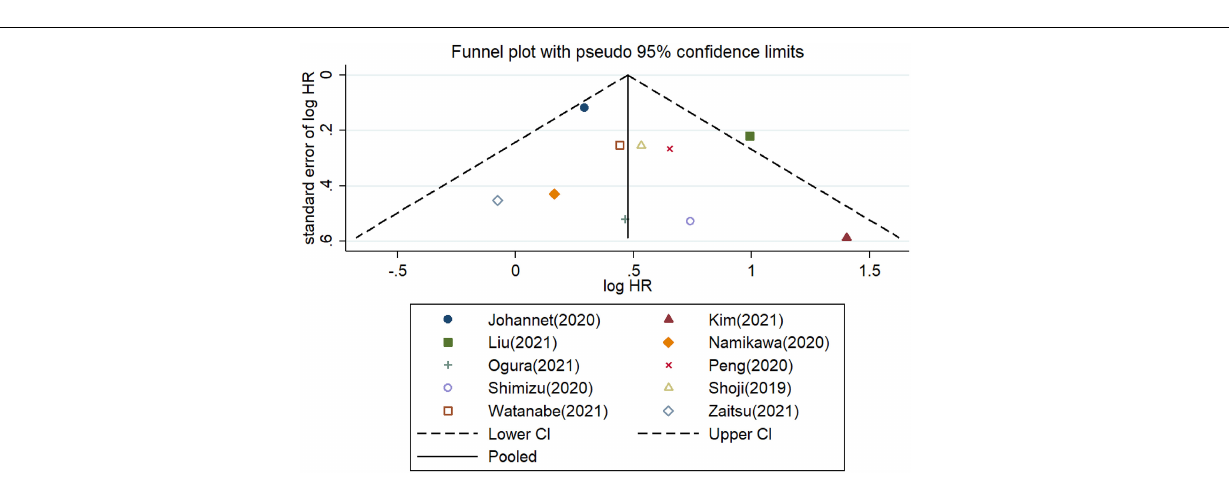
FIGURE 5 | Meta-analysis of impact of PNI on objective response rate of patients treated with immune checkpoint inhibitors.